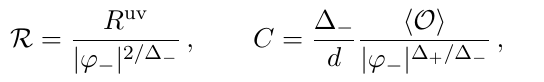
Figure 21. Plot of solutions for W ( ’ ) for (cid:13)ows exhibiting a single bounce for the potential (5.7) with (cid:1) + = 2 : 91, (cid:27) = 0 : 01, c = 2000, (cid:0) = 2 = jR 2 j > jR 1 j